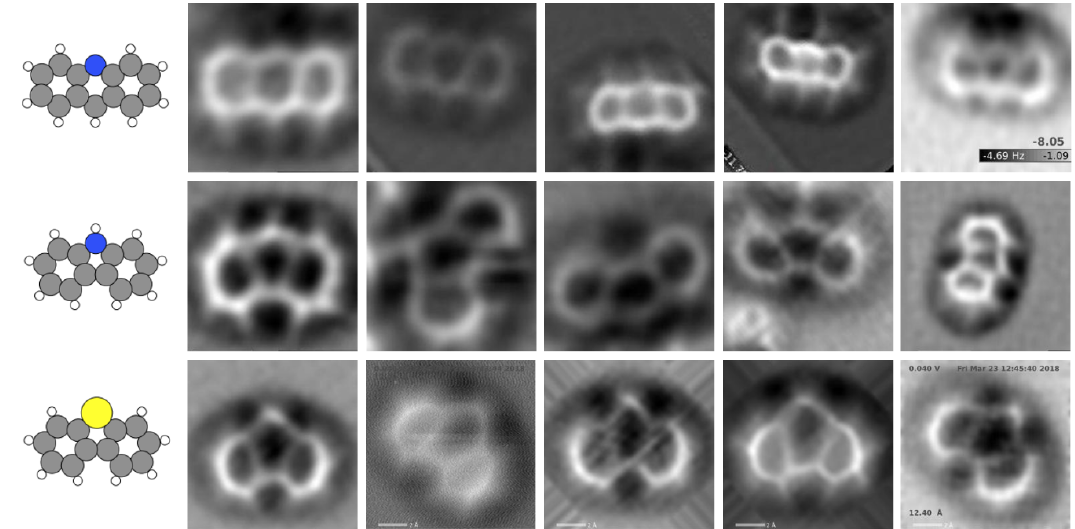
Figure 3. Experimental images for acridine, carbazole, and dibenzothiophene [47,53]. Each row shows, for the same molecule, the large variability introduced in the AFM images by different experimental conditions. This variability represents a challenge for molecular classification based on AFM. The three images in the first column were reprinted with permission from ref. [47]. Coppyright 2019 American Chemical Society. The rest of the images have been taken by Drs. P. Zahl and Y. Zhang during their work [47] and kindly provided to us